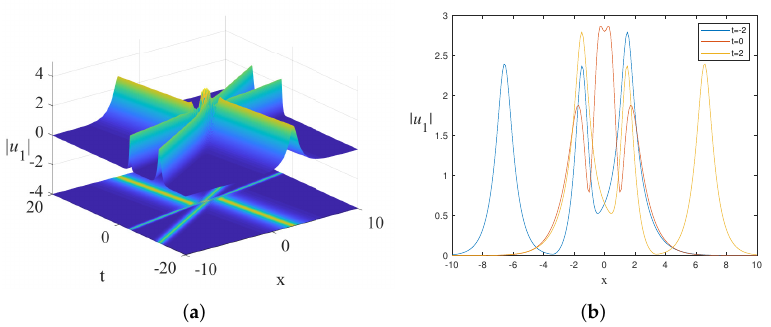
Figure 5. Three-soliton solutions | u 1 | to the mHOCLL system with n = 1: ( a ) 3D image; ( b ) plane diagrams at three different